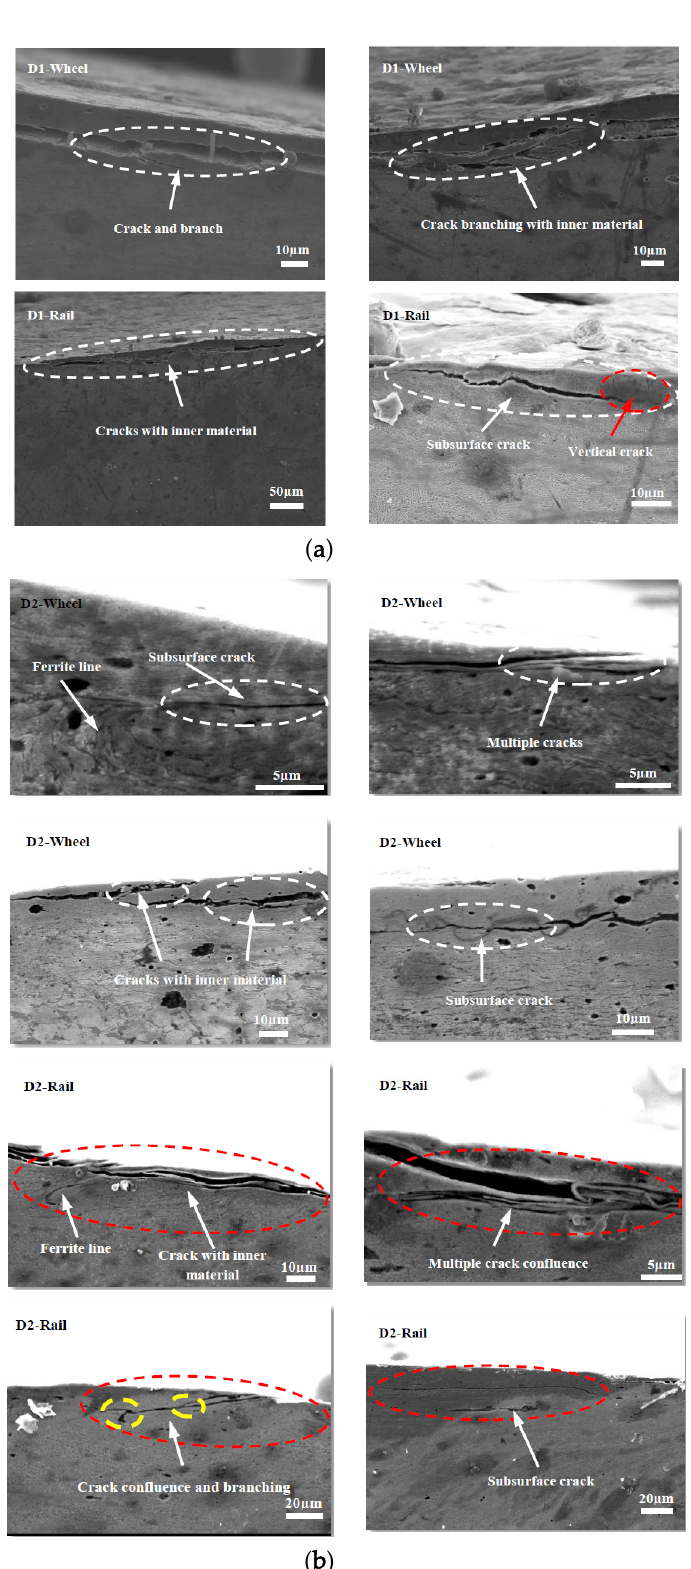
Figure 15. SEM micrographs showing the types of damage of wheel and rail rollers at 50 °C. (a) D1; (b) D2.